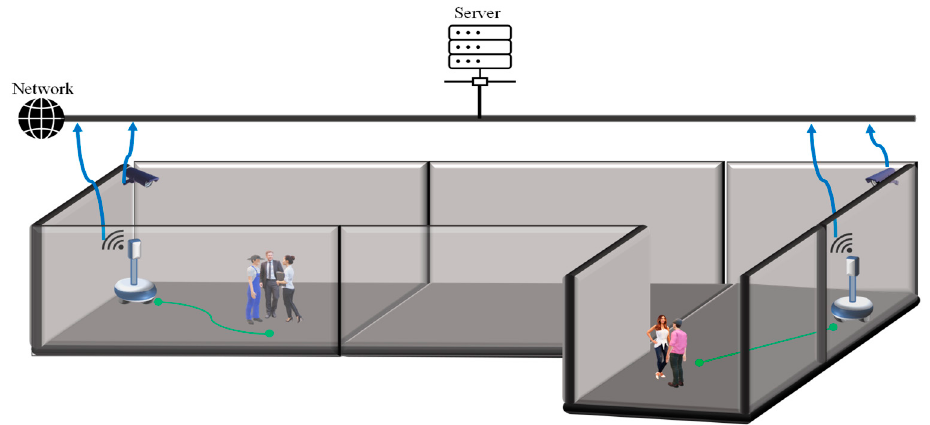
Figure 1. Multi-agent robot system.